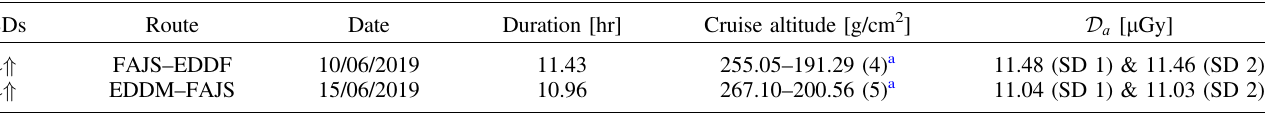
Table 1. Long-haul fl ight information.